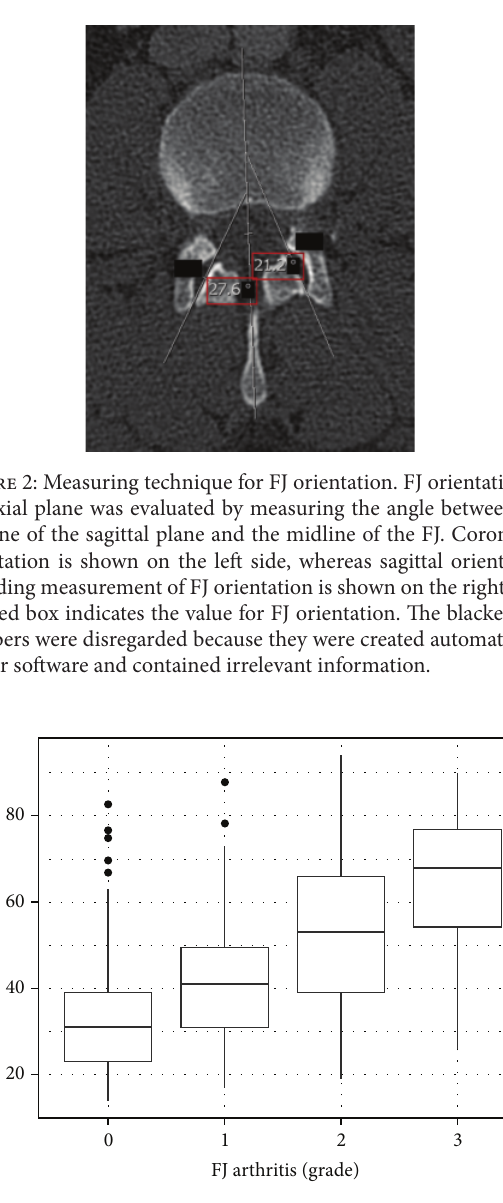
Figure 3: Grade of FJ arthritis and age. This figure describes the increasing grade of FJ arthritis with age.